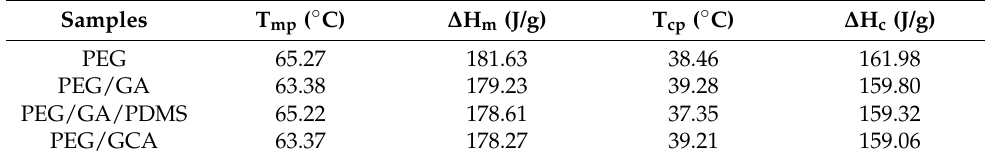
Figure 6. DSC results of ( a ) the pure PEG and PEG composites. ( b ) PEG weight fractions of the PEG composites. Table 2. Thermal characteristics of the PEG and PEG composites.